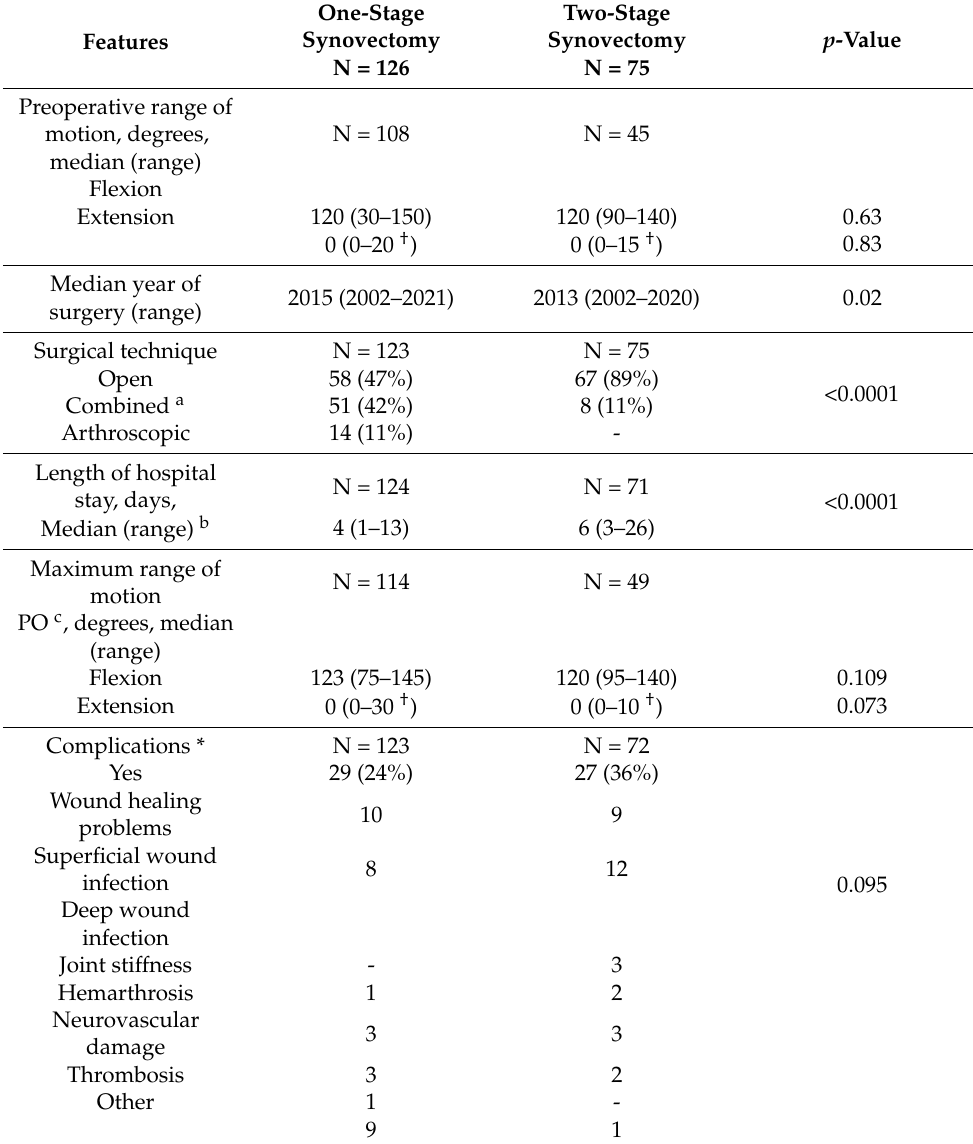
Table 2. Surgery characteristics of all